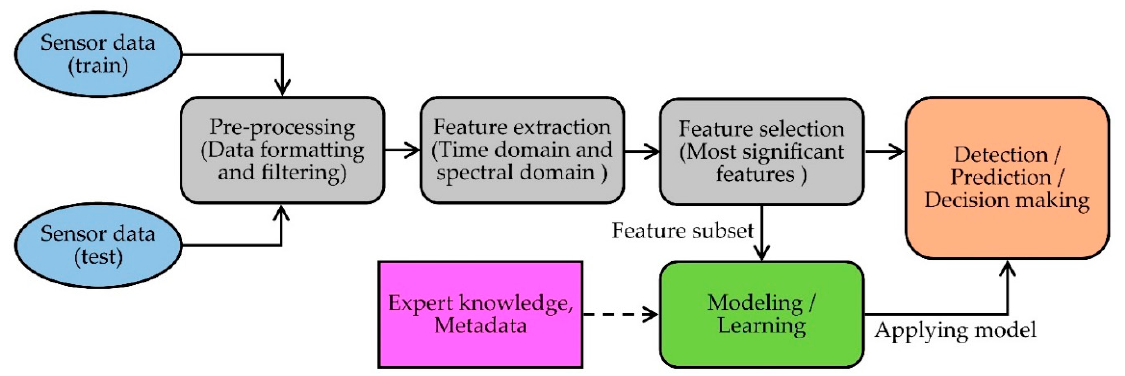
Figure 14. A generic flow diagram of a joint monitoring system.